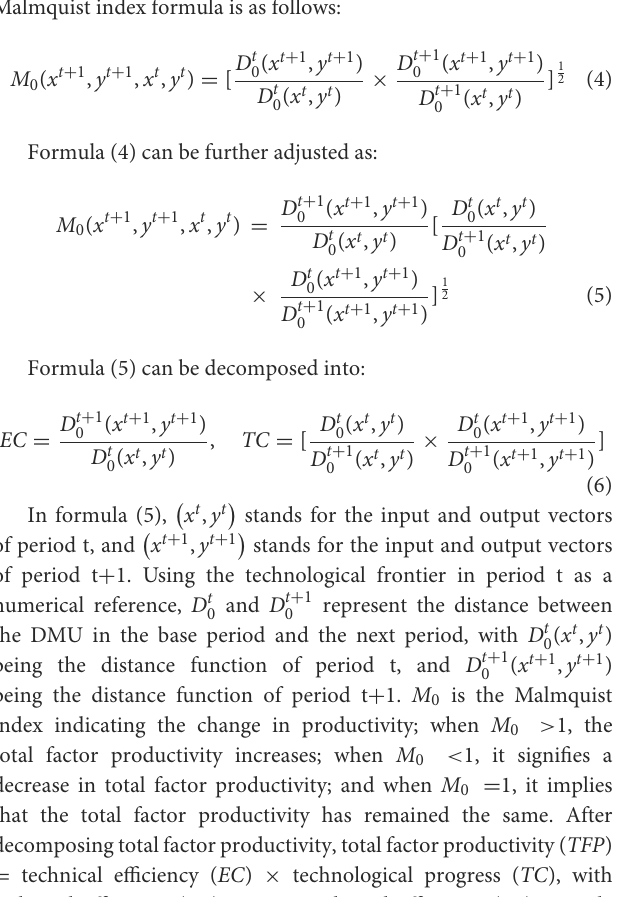
TABLE 1 Description of dependent and independent